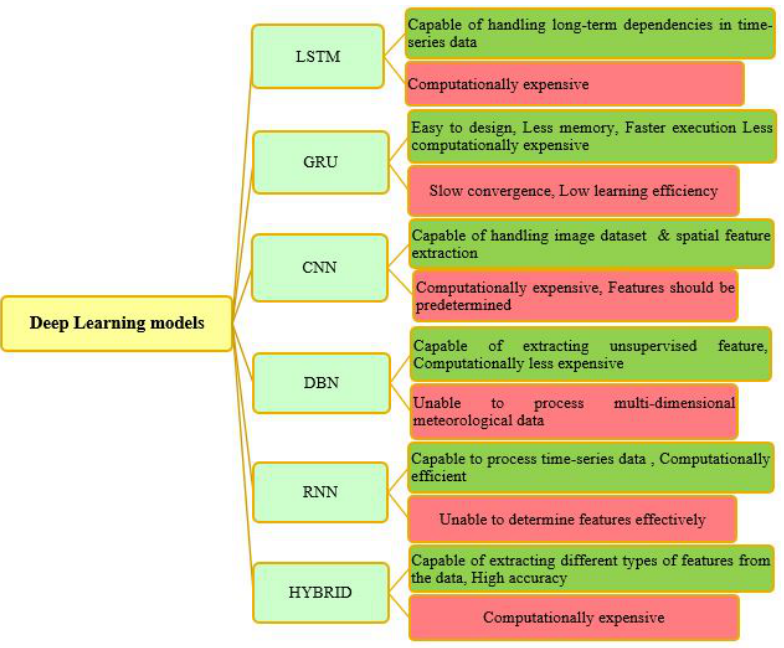
Figure 15. Pros. (Light Green) and Convs. (Light Red) of deep learning models [109]. There are two methods of supervised and unsupervised learning in deep learning. Mainly, three supervised and three unsupervised deep neural networks are discussed in this